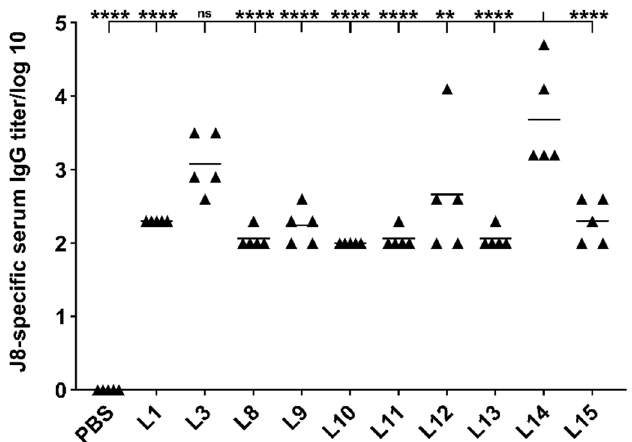
Figure 3. J8-specific antibody responses (log10) post-intranasal administration of CPP-based lipo- somes and controls in Swiss mice ( n = 5 per group), as determined by ELISA from serum collected on day 52. Statistical analysis was performed by one-way ANOVA followed by Tukey’s post hoc test to compare groups against L14 . Not significant (ns), p > 0.05; *, p < 0.05; **, p < 0.01; ***, p < 0.001; ****, p <